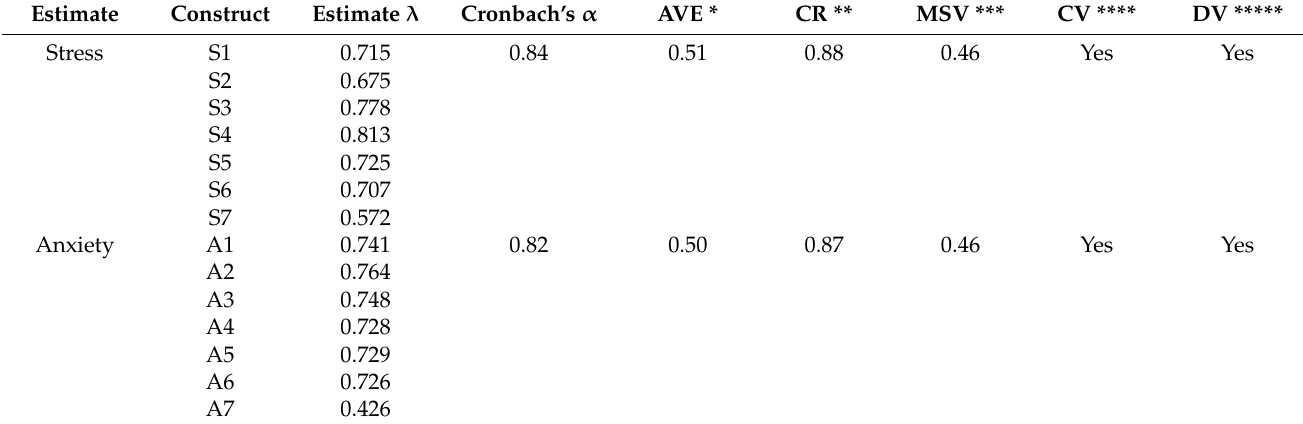
Table 1. Reliability and Construct